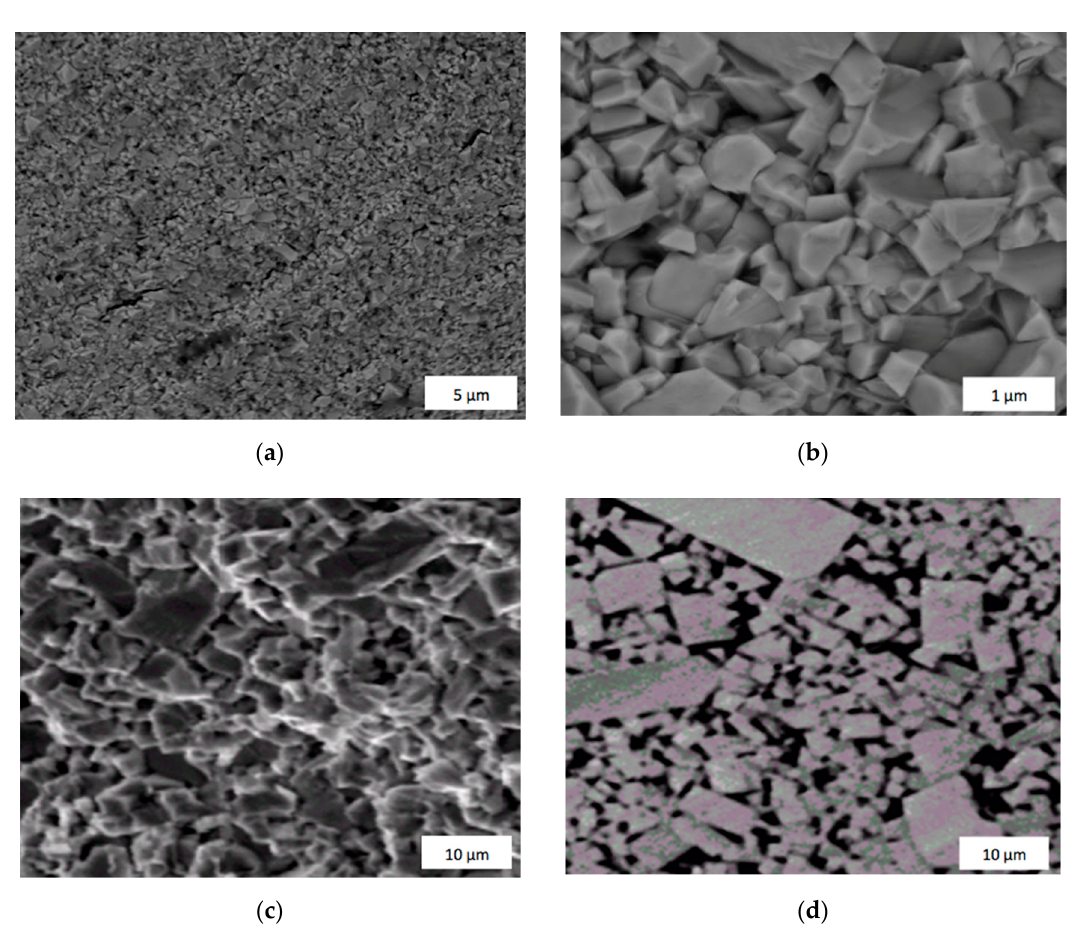
Figure 4. The fracture surfaces of sintered tungsten carbide (WC): ( a ) and ( b ) pure WC (WolCar) using the electroconsolidation method at T = 1700°C and P = 35 MPa during 3 min; ( c ) Standard blend of 8 wt.% Co and 92 wt.% of WC using conventional vacuum sintering method at T = 1350°C for 1 h, the surface without etching; ( d ) The same as ( c ), but after etching.